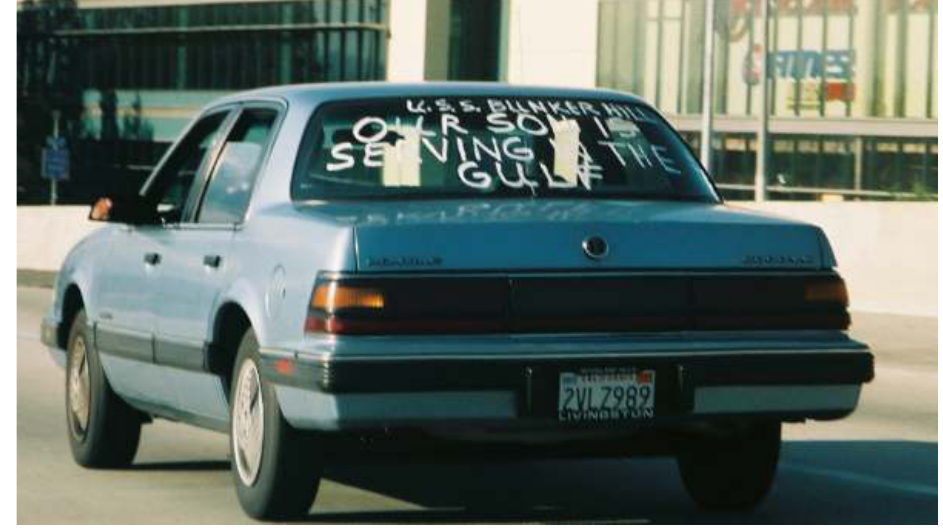
Figure 5: Patriotism prominently displayed on a car’s windshield